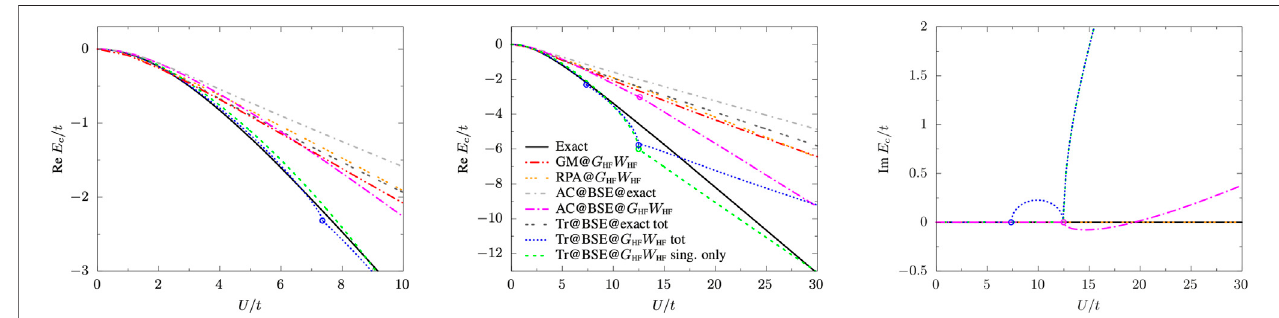
FIGURE 4 | Real and imaginary parts of the BSE@ G HF W HF correlation energy as a function of U / t at various levels of theory: total (dotted blue line) and singlet-only (dashed green line) Tr@BSE, AC@BSE (dot-dashed magenta line), RPA (triple-dotted orange line), GM (double-dot-dashed red line), and exact (solid black line). For comparison also the BSE@exact (Tr@BSE, double-dotted dark grey line; AC@BSE, dot-dashed light grey line) correlation energies are shown. Discontinuitiesin the fi rst derivative of the energy (corresponding to the appearance of complex poles) are indicated by open circles.